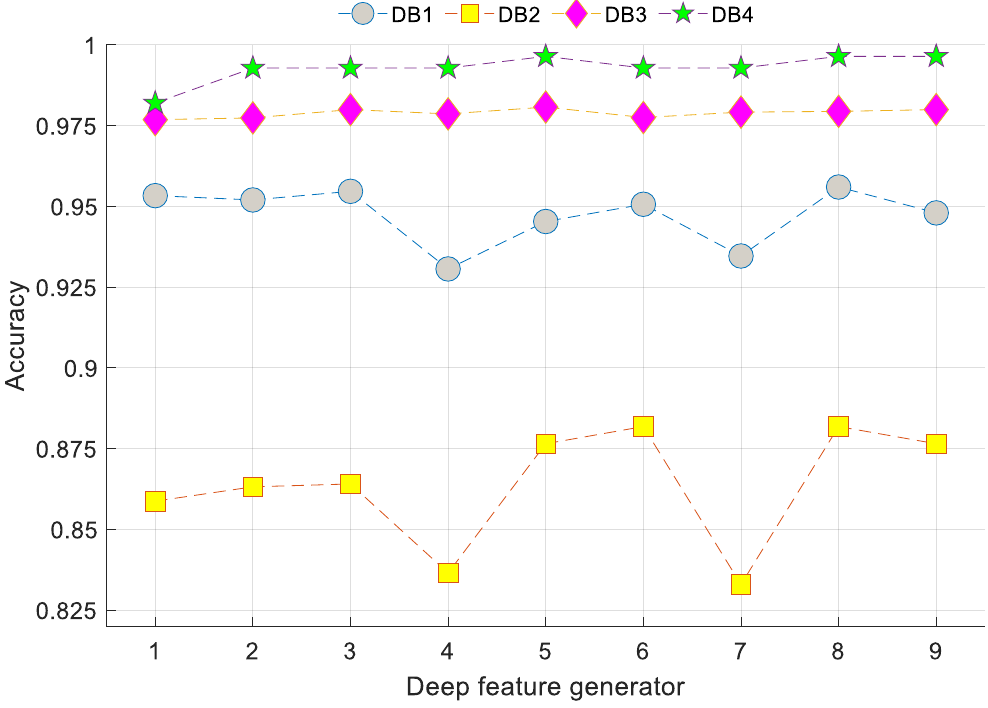
Figure 9. Graph of accuracies versus number of features used for various datasets used.